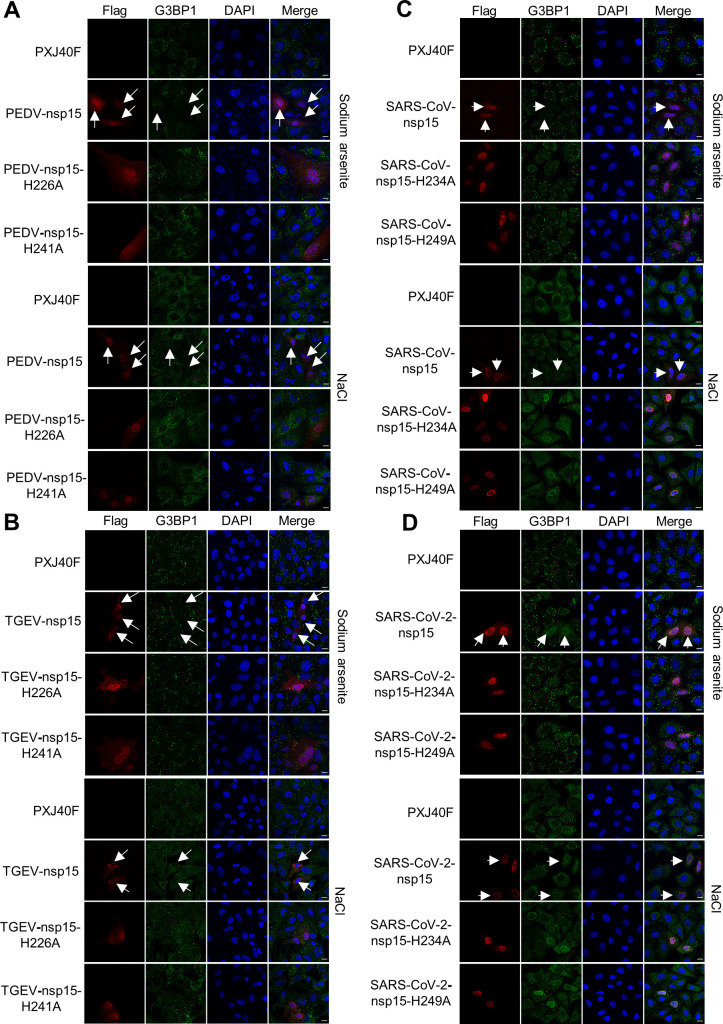
Nsp15s from PEDV, TGEV, SARS-CoV, SARS-CoV-2 harbor the conserved function to inhibit eIF2α-dependent and -independent formation of SGs, and the endoribonuclease activity is required.LLC-PK1, ST or HeLa cells were transfected with plasmids encoding Flag-tagged nsp15s or their catalytic defective mutants (H-A) from PEDV (LLC-PK1 cells), TGEV (ST cells), SARS-CoV (HeLa cells), SARS-CoV-2 (Hela cells), respectively. At 24 h post-transfection, cells were received sodium arsenite or NaCl treatment. The cells expressing Flag-tagged nsp15s or catalytic defective mutants were detected with anti-Flag antibody (red) and the formation of SGs was detected with anti-G3BP1 (green). Cell nuclei were stained with DAPI (blue). The representative images of three independent experiments were shown. Scale bars: 10 μm.